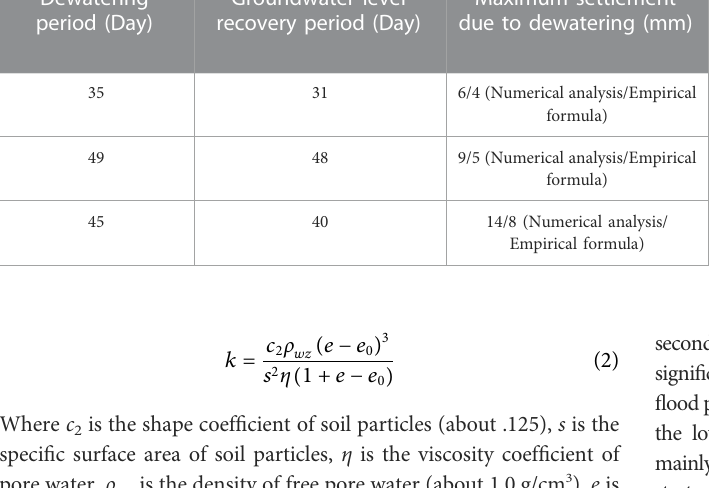
TABLE 4 Summary of settlement deformation triggered by dewatering and pit excavation of metro station pit on Line 14. Dewatering period